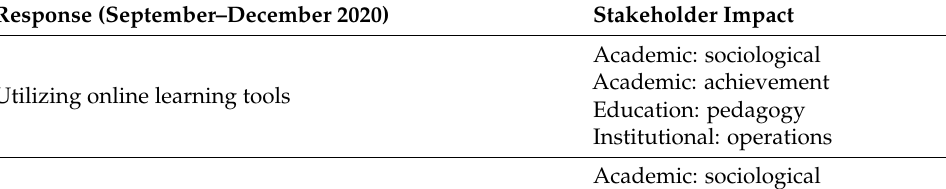
Table 6. Impacts of the COVID-19 response for the second semester of 2020 at Graduate School